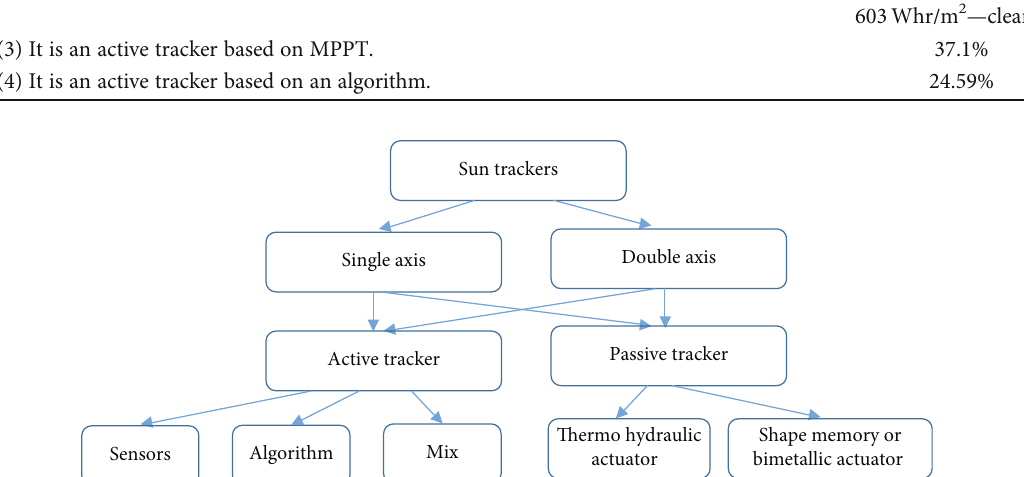
Figure 1: Classi fi cation of sun